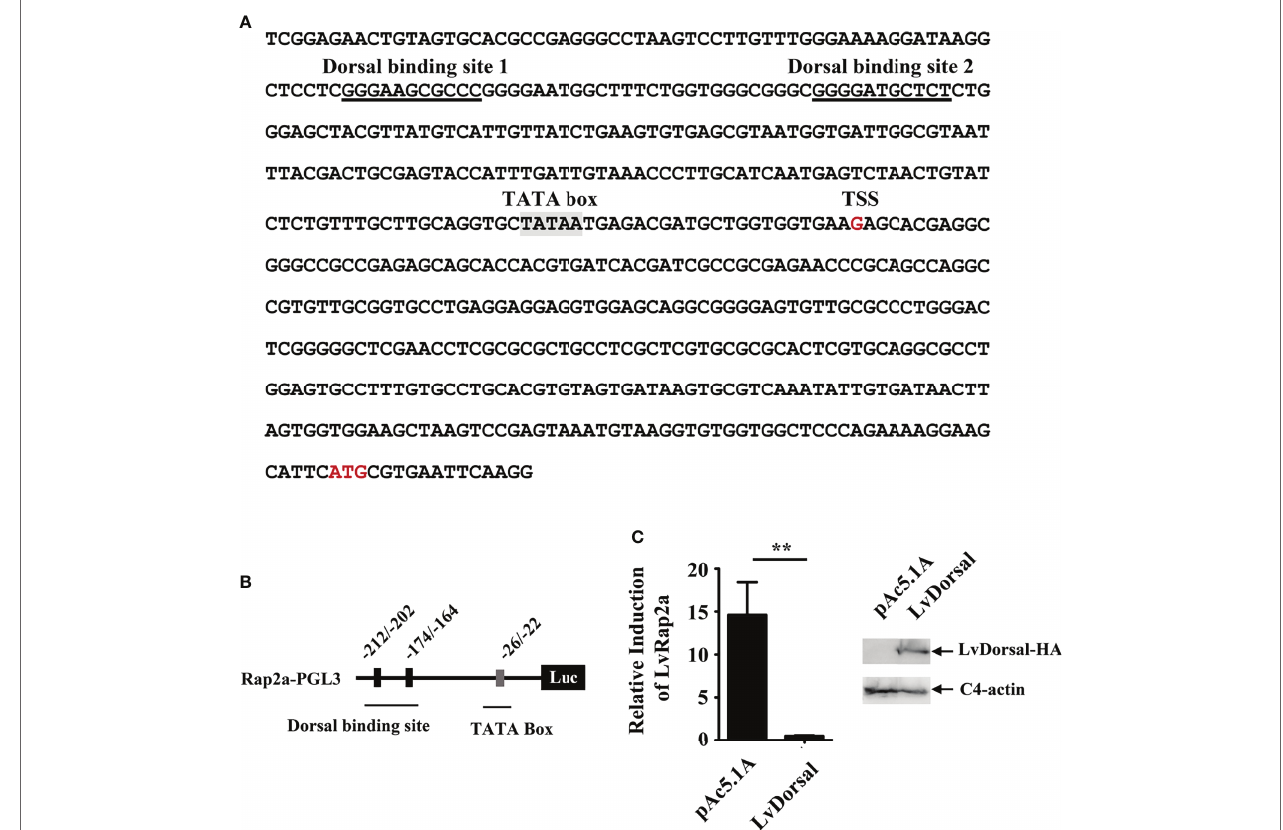
FIGURE 6 | Over-expression of LvDorsal in vitro inhibited LvRap2a induction. (A) The promoter sequences of LvRap2a. The potential Dorsal binding motifs on the promoter of LvRap2a were underlined with black lines and the TATA box was shaded in grey. (B) The structure of the promoter of LvRap2a. There are two putative Dorsal binding motifs located at -212 to -202 and -174 to -164. (C) LvDorsal negatively regulated the promoter activity of LvRap2a in vitro . After 48 h, the cells were harvested for measurement of luciferase activity using the dual-luciferase reporter assay system. Western blotting was performed to confirm LvDorsal expression. C4 actin was used as a protein loading control. Asterisks indicate significant differences (** p < 0.01). All the experiments (C) were performed two times with identical results.